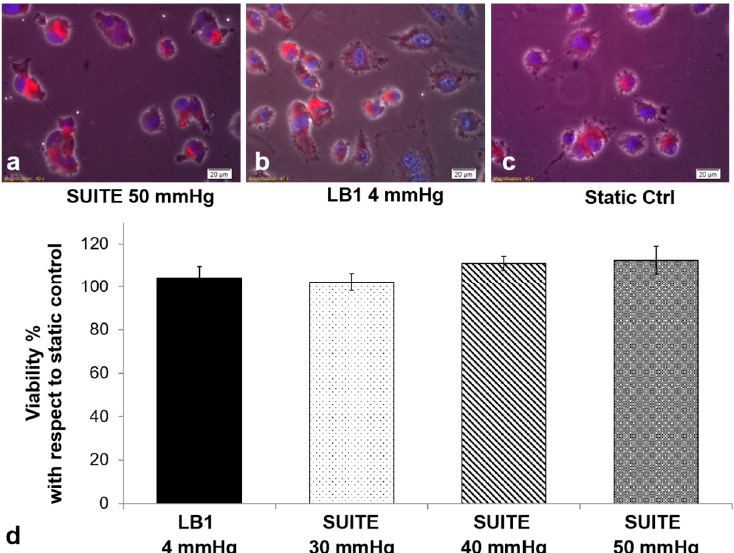
Figure 6. ( a – c ) Fluorescence micrographs of endothelial cells stained with DAPI (blue) and vWF (red). ( d ) Viability of HUVEC cells after 4 h in the SUITE system at different hydrostatic pressures, compared with dynamic controls placed in the traditional incubator (in LB1). Data are expressed as a percentages with respect to static